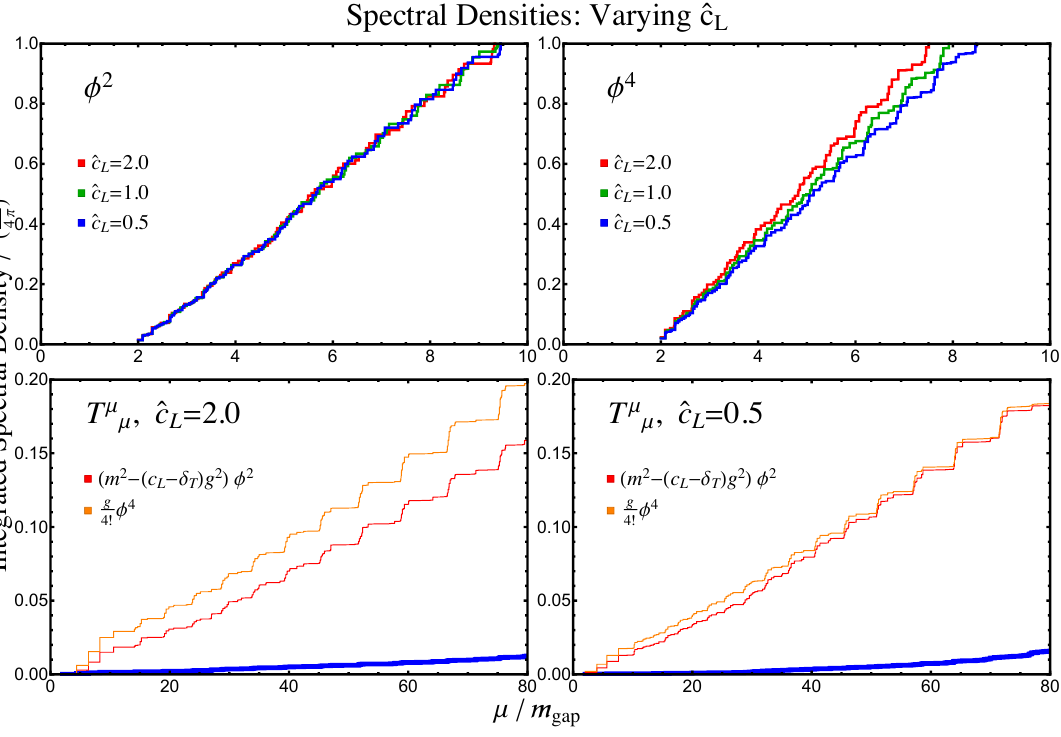
= 1 . 0 (top row) and of T µ at µ g/ 4 π L